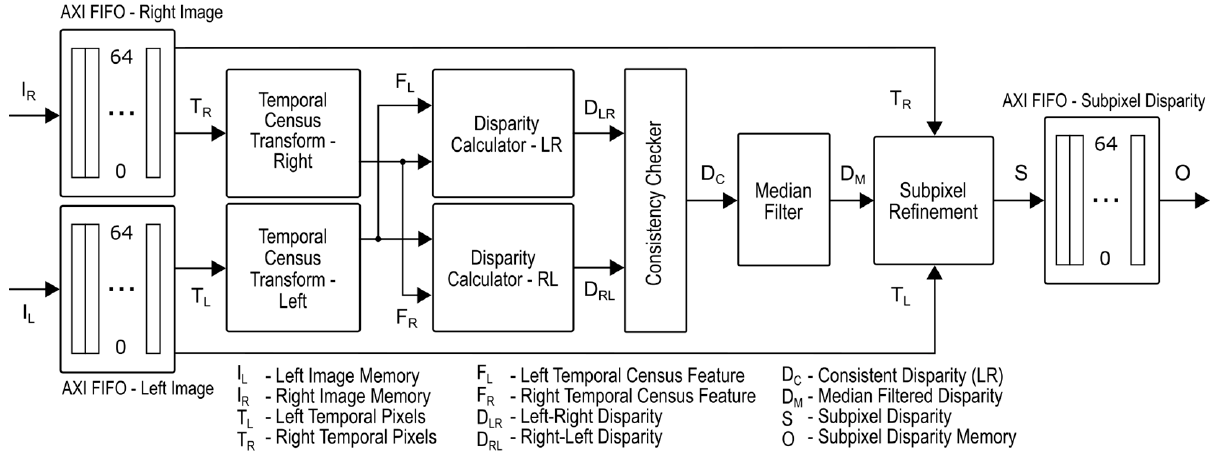
Figure 2. High-level structure of the proposed FPGA-based design.